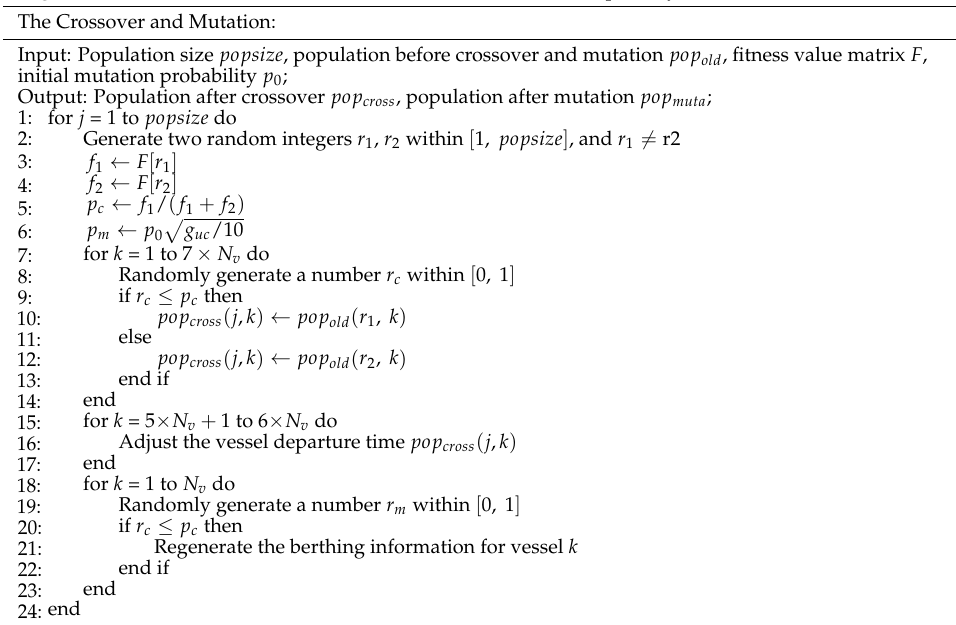
Algorithm 1 . Pseudo code of crossover and mutation (Source: compiled by